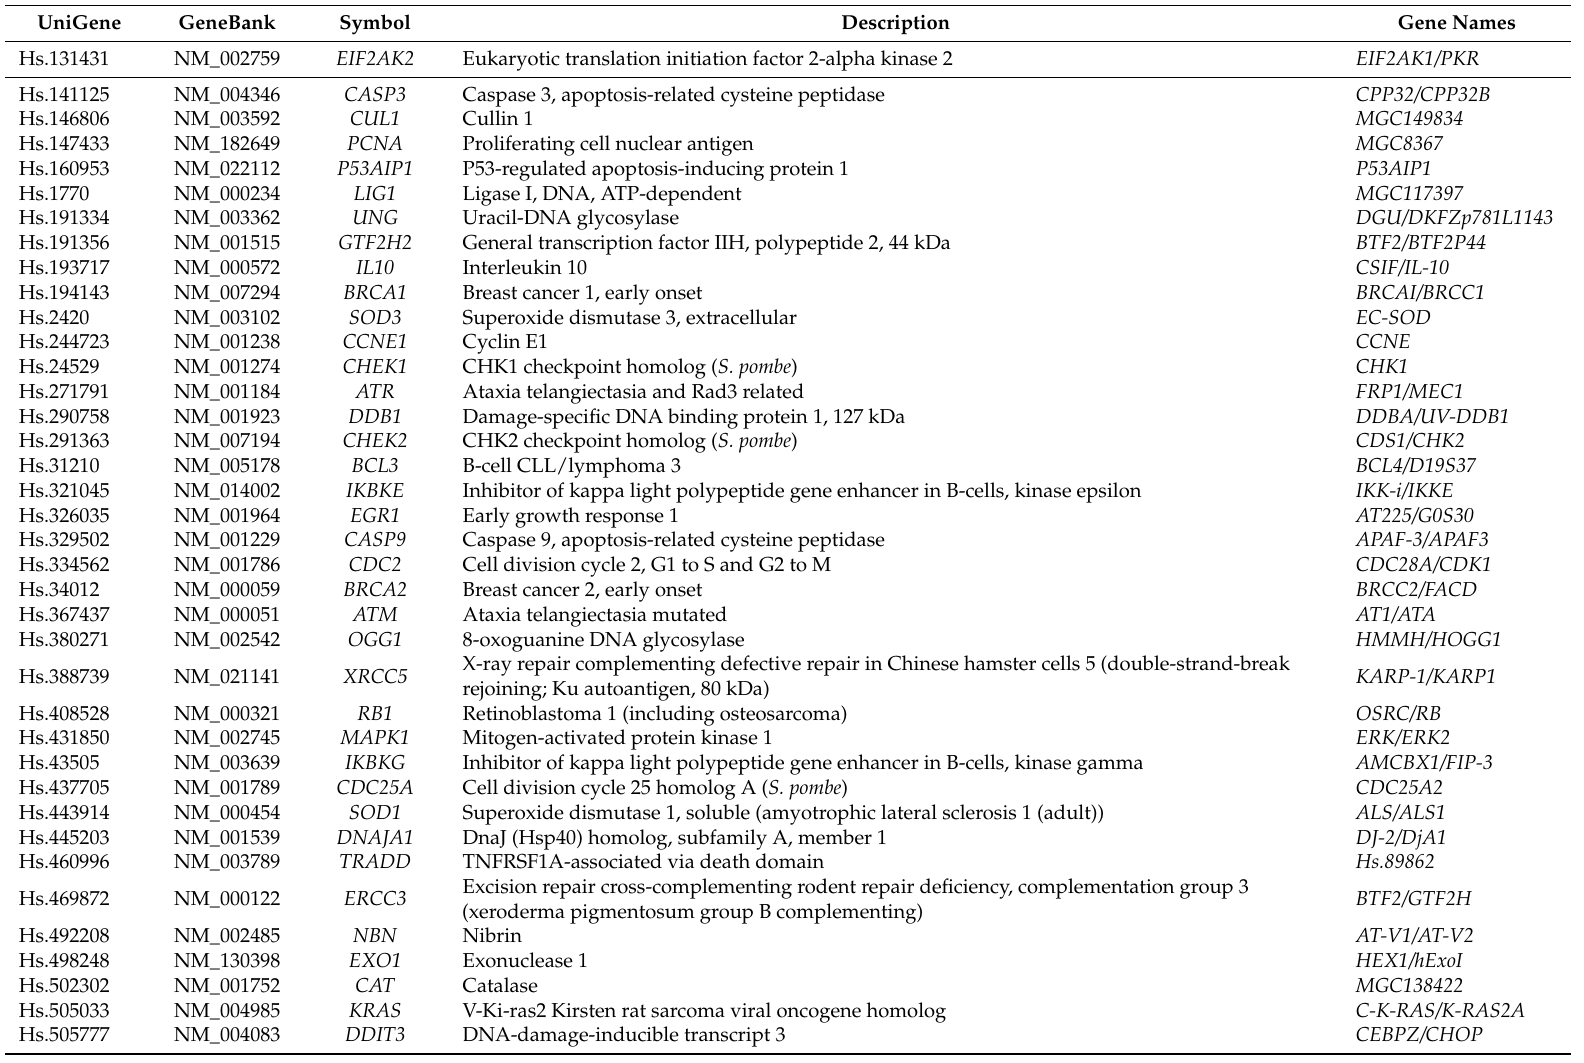
Table A2. List Additional Genes of the Customized QPCR